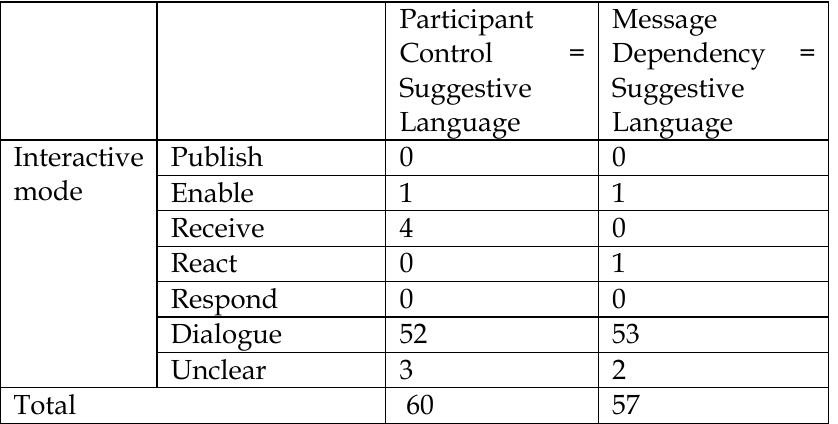
Participant Message Control = Dependency = Suggestive Suggestive Language